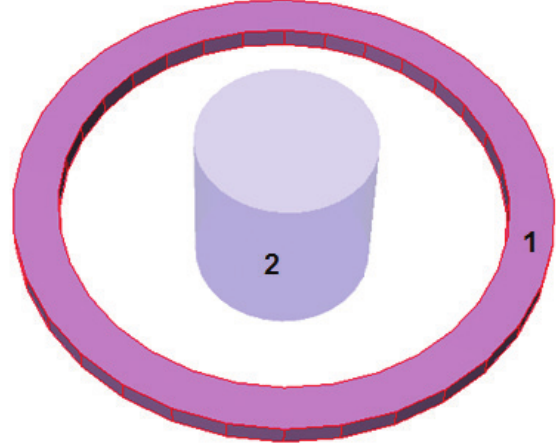
Figure 3. Computational geometry in modeling of spectra from waste-containing casks: 1 – ring-shaped detector with a lead col- limator; 2 – cask with